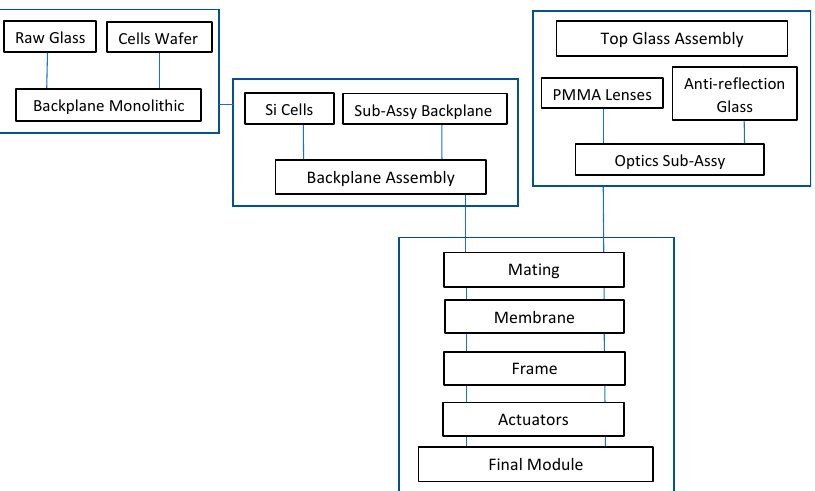
Figure 2. Flow diagram of the HCPV module production process.